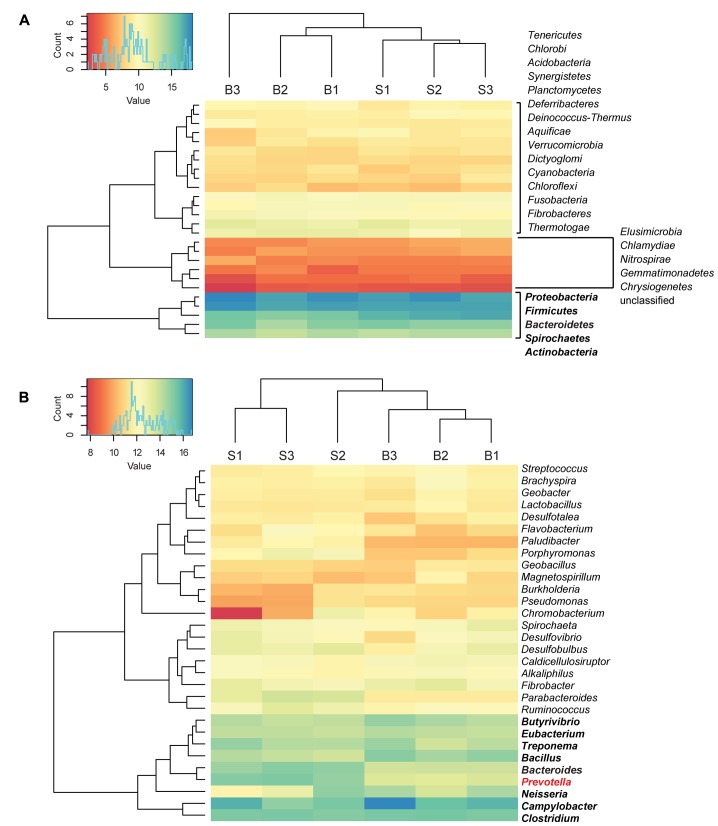
Taxonomic distribution of bacterial reads. Read count values are given as transformed log2 values of normalized counts per phylotype. Based on the dendrogram’s branching hierarchy, a ‘high abundance cluster’ was defined and marked in bold. Statistically significant differences of phylotypes between baseline (B) and SARA (S) samples were colored red. All phyla detected are shown in (A), the 30 most abundant genera are shown in (B).